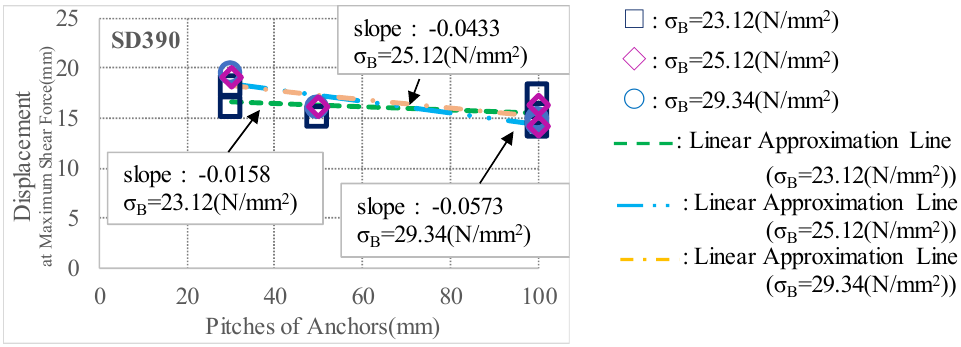
Figure 8. Displacement at maximum shear force - pitches of anchors relations. (SD390)